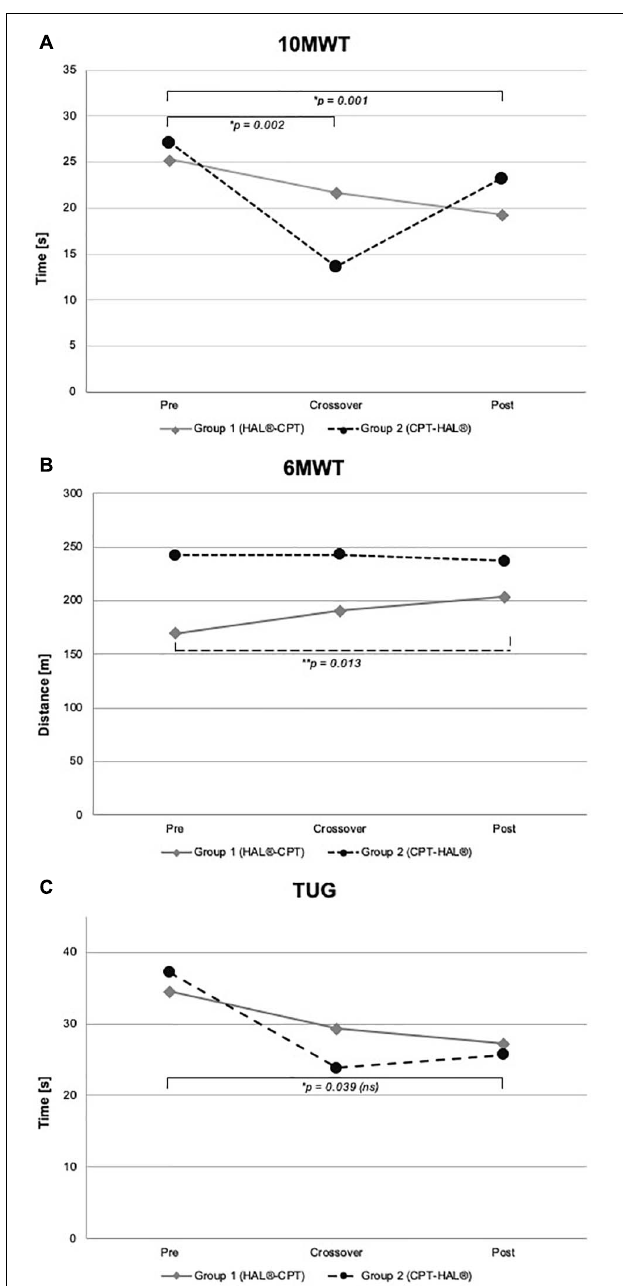
FIGURE 3 | Walking performance parameter. Walking abilities at baseline, crossover and at the end of the study. Figure shows mean values for Group 1 (HAL-CPT) and Group 2 (CPT-HAL). Ten MWT = 10-meter walking test (A) , 6 MWT = 6-min walking test (B) , TUG = timed-up-and-go test (C) . ∗ indicated post hoc t -tests after significant effect for factor “time,” ∗∗ indicated post hoc t -test after significant interaction between “time” and “Group” (see “Results” section for details). p -threshold < 0.017 (Bonferroni correction).